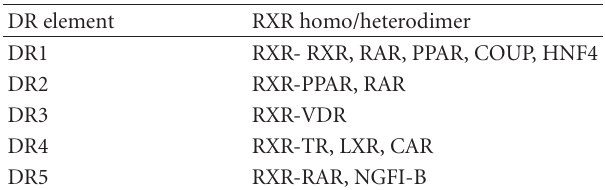
Table 1: DR element binding properties of RXR homodimers and